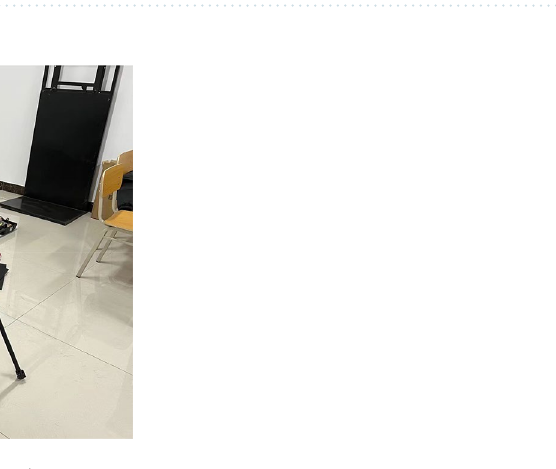
Figure 4. Grid diagram of the central axis (Abaqus v6.3).